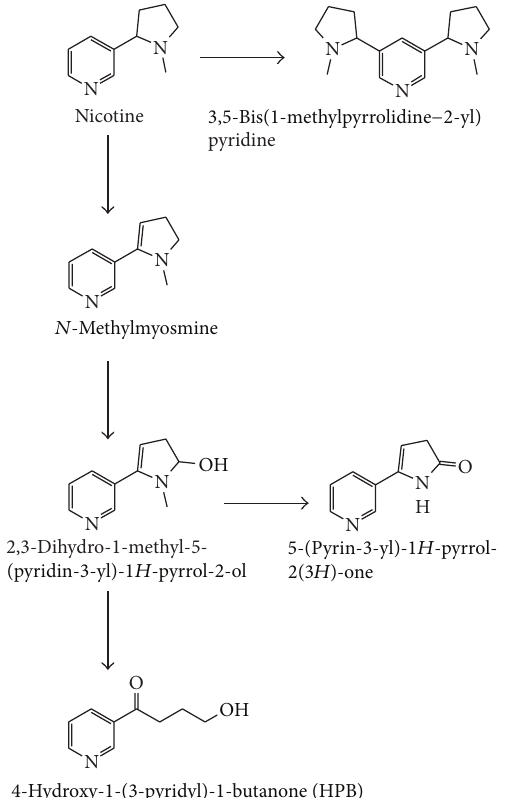
Figure 3: A variant pyrrolidine pathway of nicotine biodegradation by P. plecoglossicida TND35.